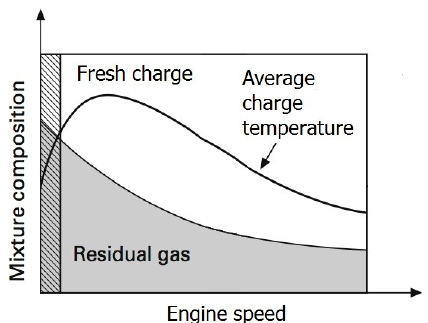
Figure 1. Variation of average charge temperature at the start of compression ( T epc ), quantity of fresh charge and residual gas against engine speed in a typical two-stroke cycle engine [25].